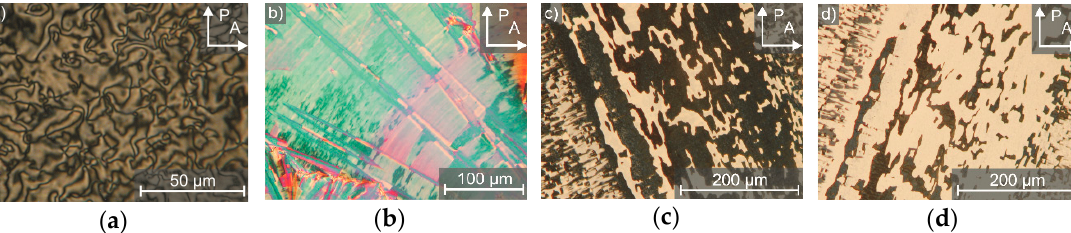
Figure 11. Typical textures of the lyotropic SmC* phase observed by polarized optical microscopy. In thicker samples ( a ) Schlieren textures and ( b ) broken fans with zigzag defects appear. ( c ) In the surface stabilized state, bright and dark domains in the range of several hundred micrometers with opposite tilt directions can be observed. ( d ) By rotating the sample between crossed polarizers (P and A), the brightness of the tilt domains reverses. (Reprinted by permission from John Wiley and Sons: [29].)